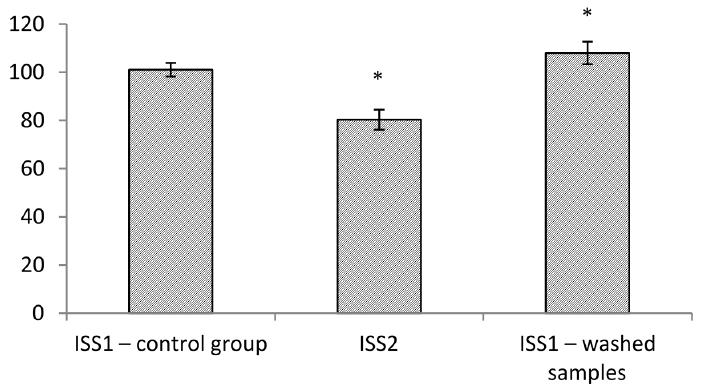
Figure 2. Comparison of the amplitude of focal response, expressed as a percentage in reference to